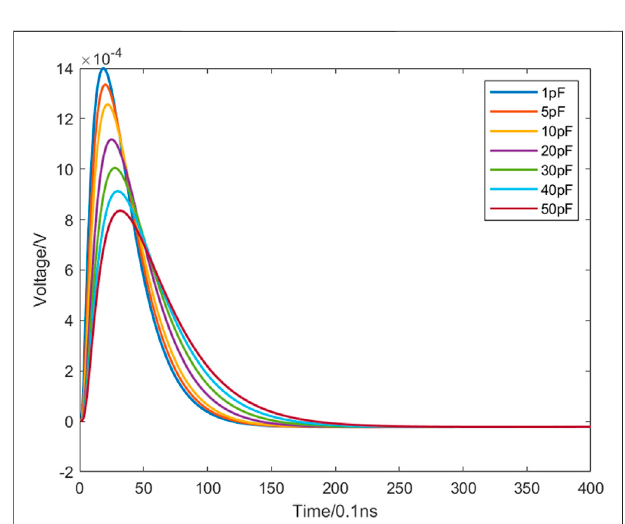
FIGURE 12 | Frequency response with different stray inductance.